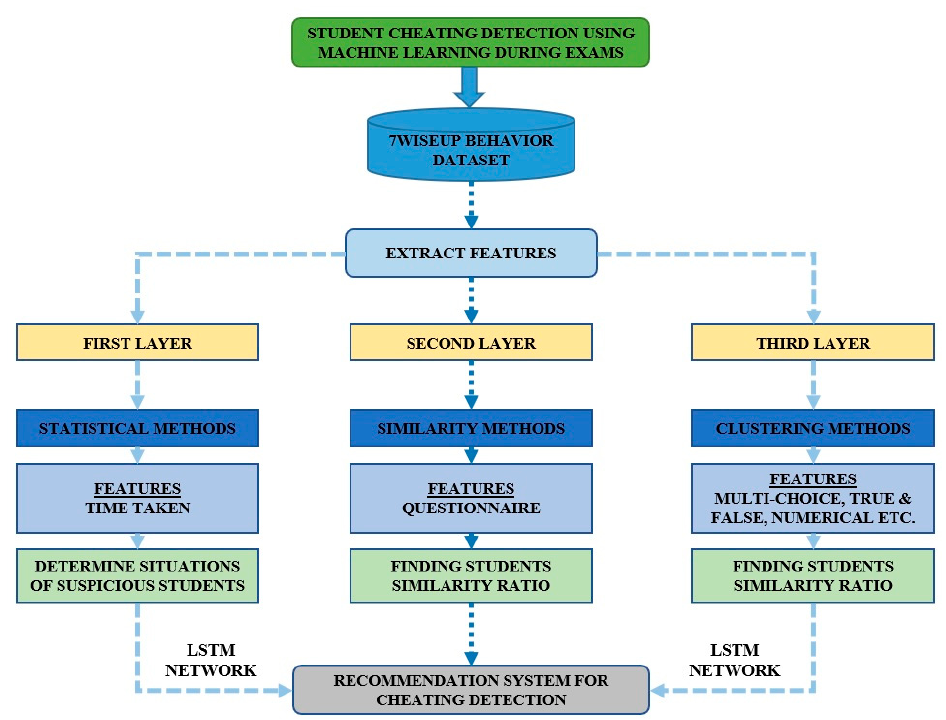
Figure 8. Proposed methodology for student cheating detection system.